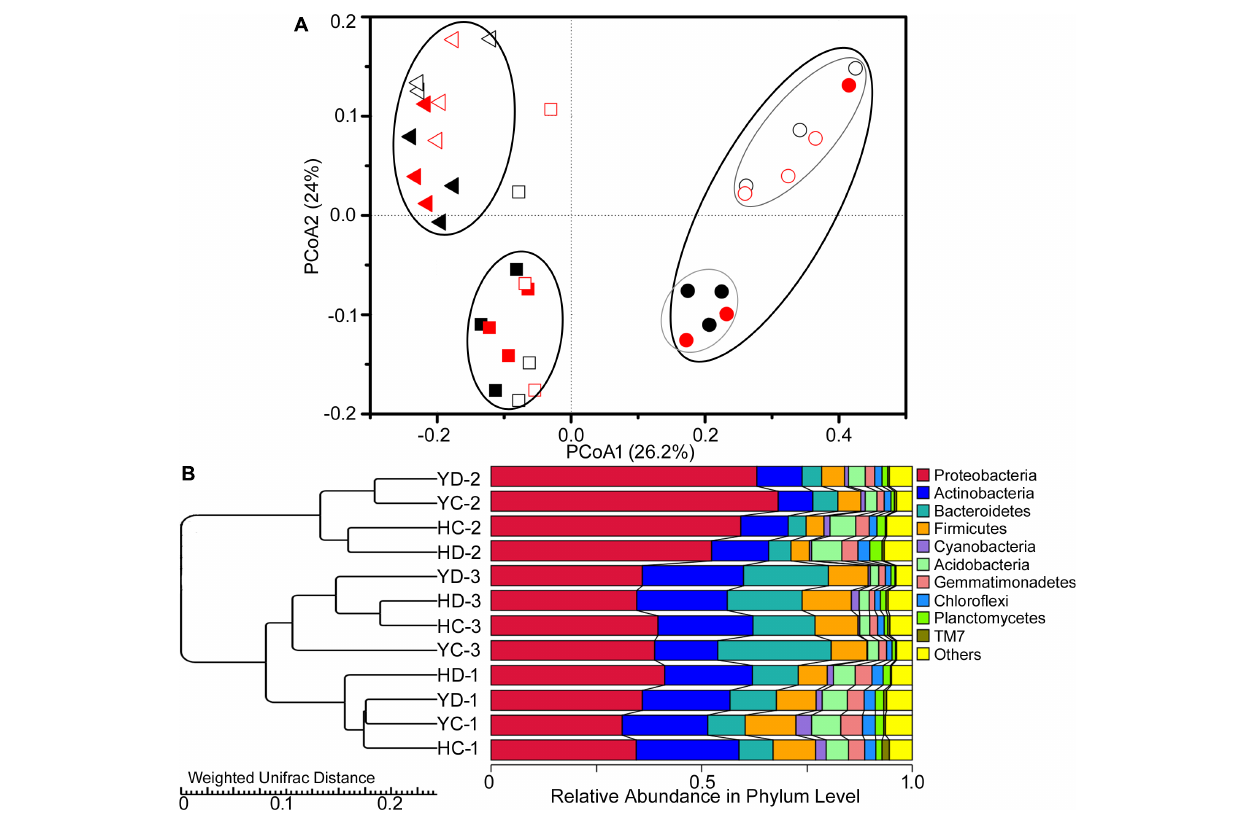
FIGURE 1 | Variations in the composition of the bacterial rhizosphere community of HQR and YL10 at distinct developmental stages and under drought stress. (A) Principal coordination analysis (PCoA) based on the weighted UniFrac distances. Square, jointing stage; circular, flowering stage; triangle, grain filling stage. Black, control; red, drought treatment. The solid square, circular, and triangle represent HQR, whereas the open ones represent YL10. (B) UPGMA clustering using Weighted UniFrac Distances. H = HQR; Y = YL10; C = control, D = drought stress; 1 = jointing stage; 2 = flowering stage; 3 = grain filling stage.